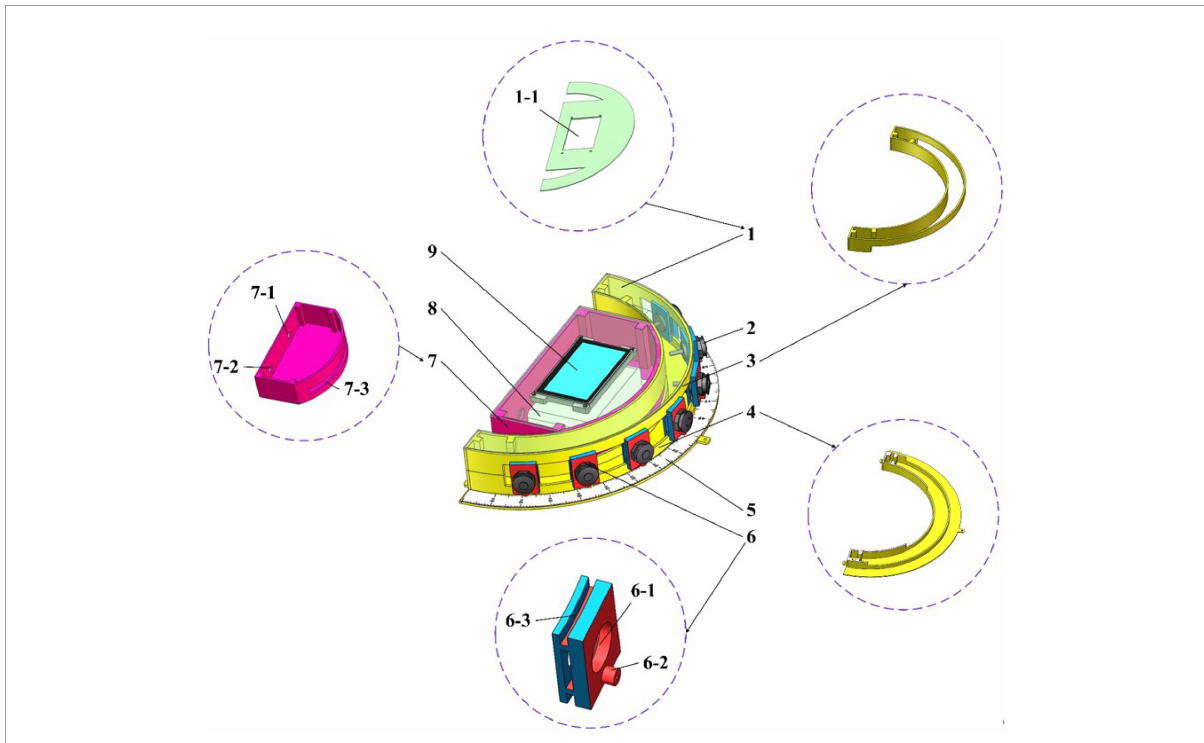
FIGURE11 A structure of a circular arc array edge navigation sensor module: (1) An upper cover, (1-1) A man-machine interaction display mounting port, (2) A ranging sensor, (3) An arc chute half-round shell, upper part, (4) A lower part of an arc chute semicircular shell, (5) A calibration plate for central angle adjustment, (6) An angle-sliding adjustment plate, (6-1) A range sensor, (6-2) A bottom positioning bolt hole, (6-3) A chute, (7) Embedded System-integrated housing, (7-1) A power input port, (7-2) A navigation signal output port, (7-3) A range finder through a slot, (8) Embedded-controller housing, (9) A man-machine interaction display screen.